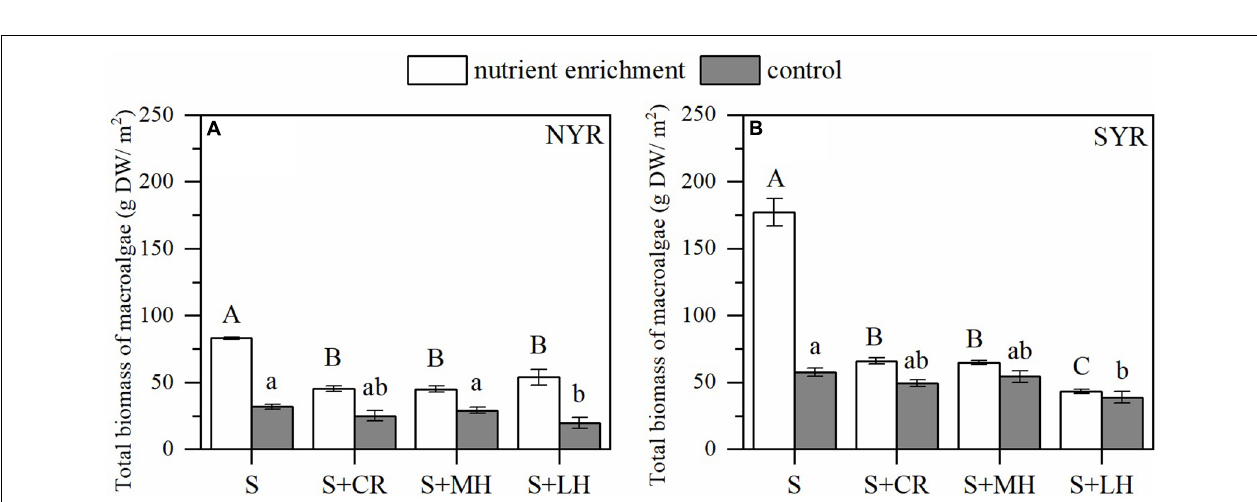
Frontiers in Marine Science |